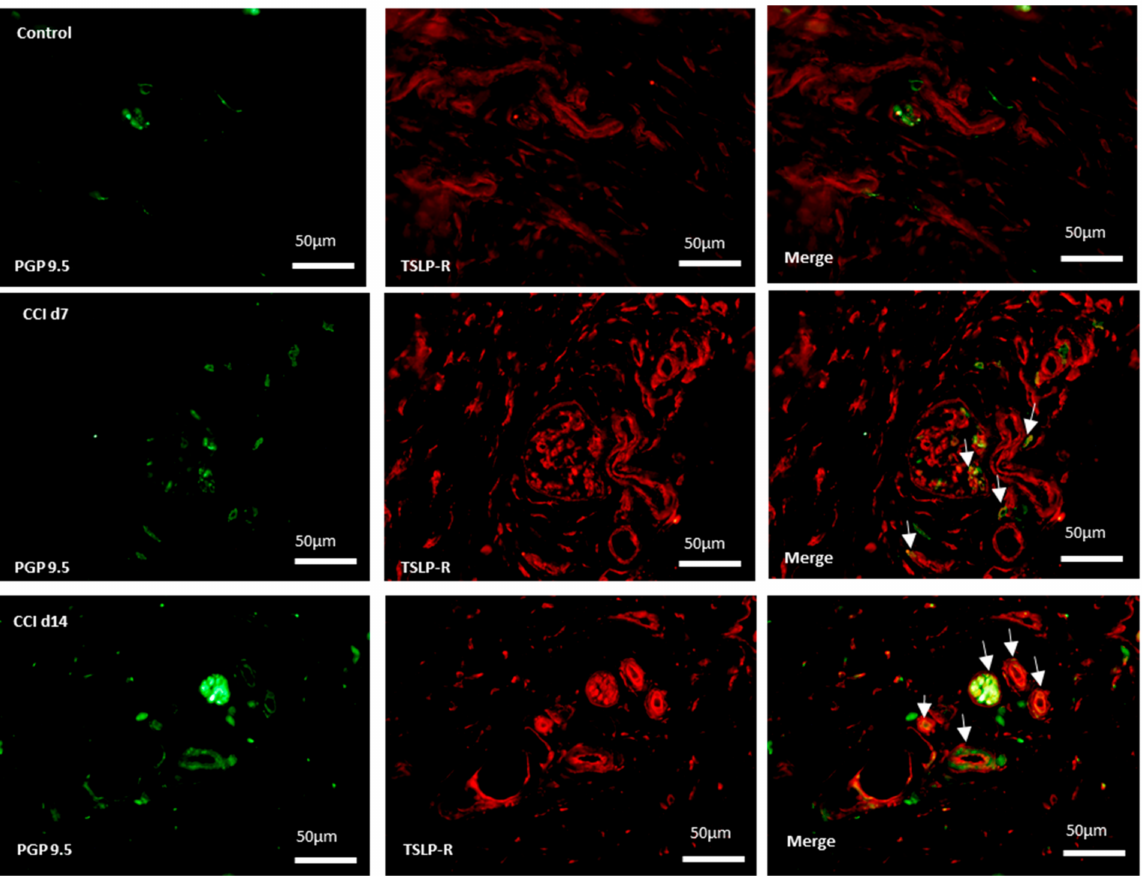
Figure 4. Expression of TSLPR in sensory terminals in ipsilateral skin after CCI. Representative double immunofluorescence labelling results for TSLPR (red) and PGP 9.5 (green) in the hind-paw skin. Scale bar, 50 µ m. Pairs of images are merged. White arrows indicate doubled-labeled cells. N = 6 per